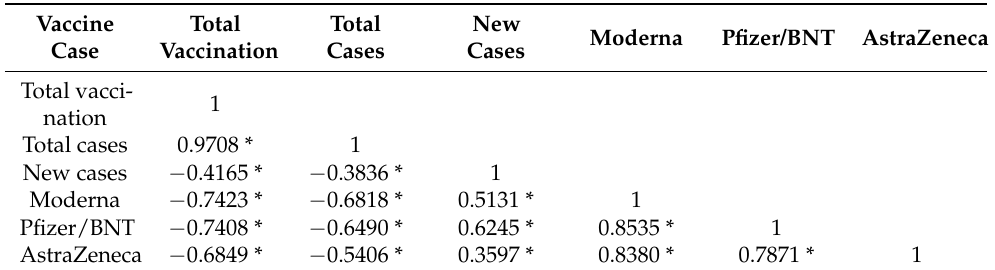
Table 3. The Pearson correlations between, total vaccinations, total cases, new cases, Moderna, Pfizer/BNT, and AstraZeneca.